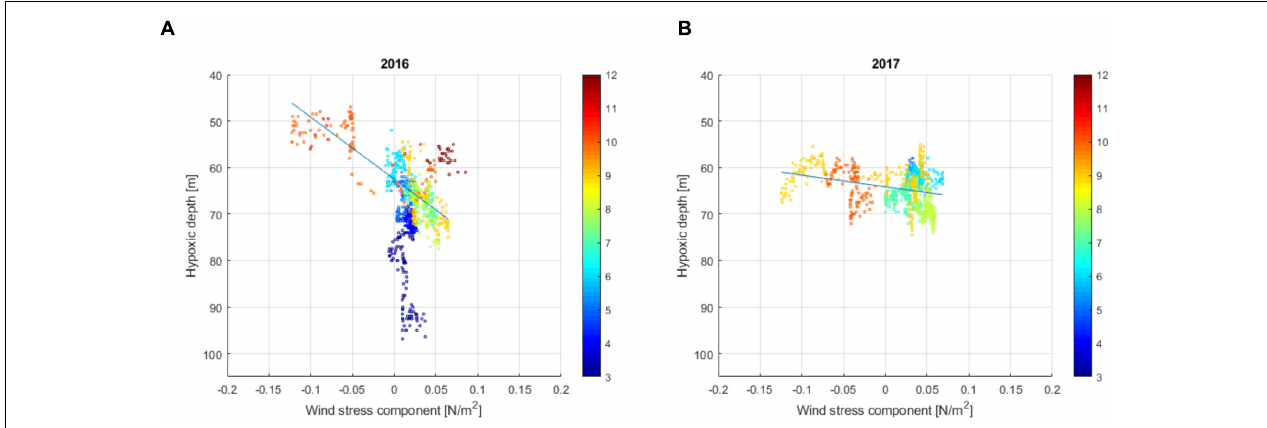
FIGURE 5 | The relationship between the depth of hypoxia and the 3-week average wind stress component from N-NE (20 π ) at the Keri station in 2016 [ (A) ; R 2 = 0.60, p < 0.05] and 2017 [ (B) ; R 2 = 0.08, p < 0.05]. Wind data from Kalbådagrund are used (see Figure 1 for location). The color bar shows the time of measurements (in months).